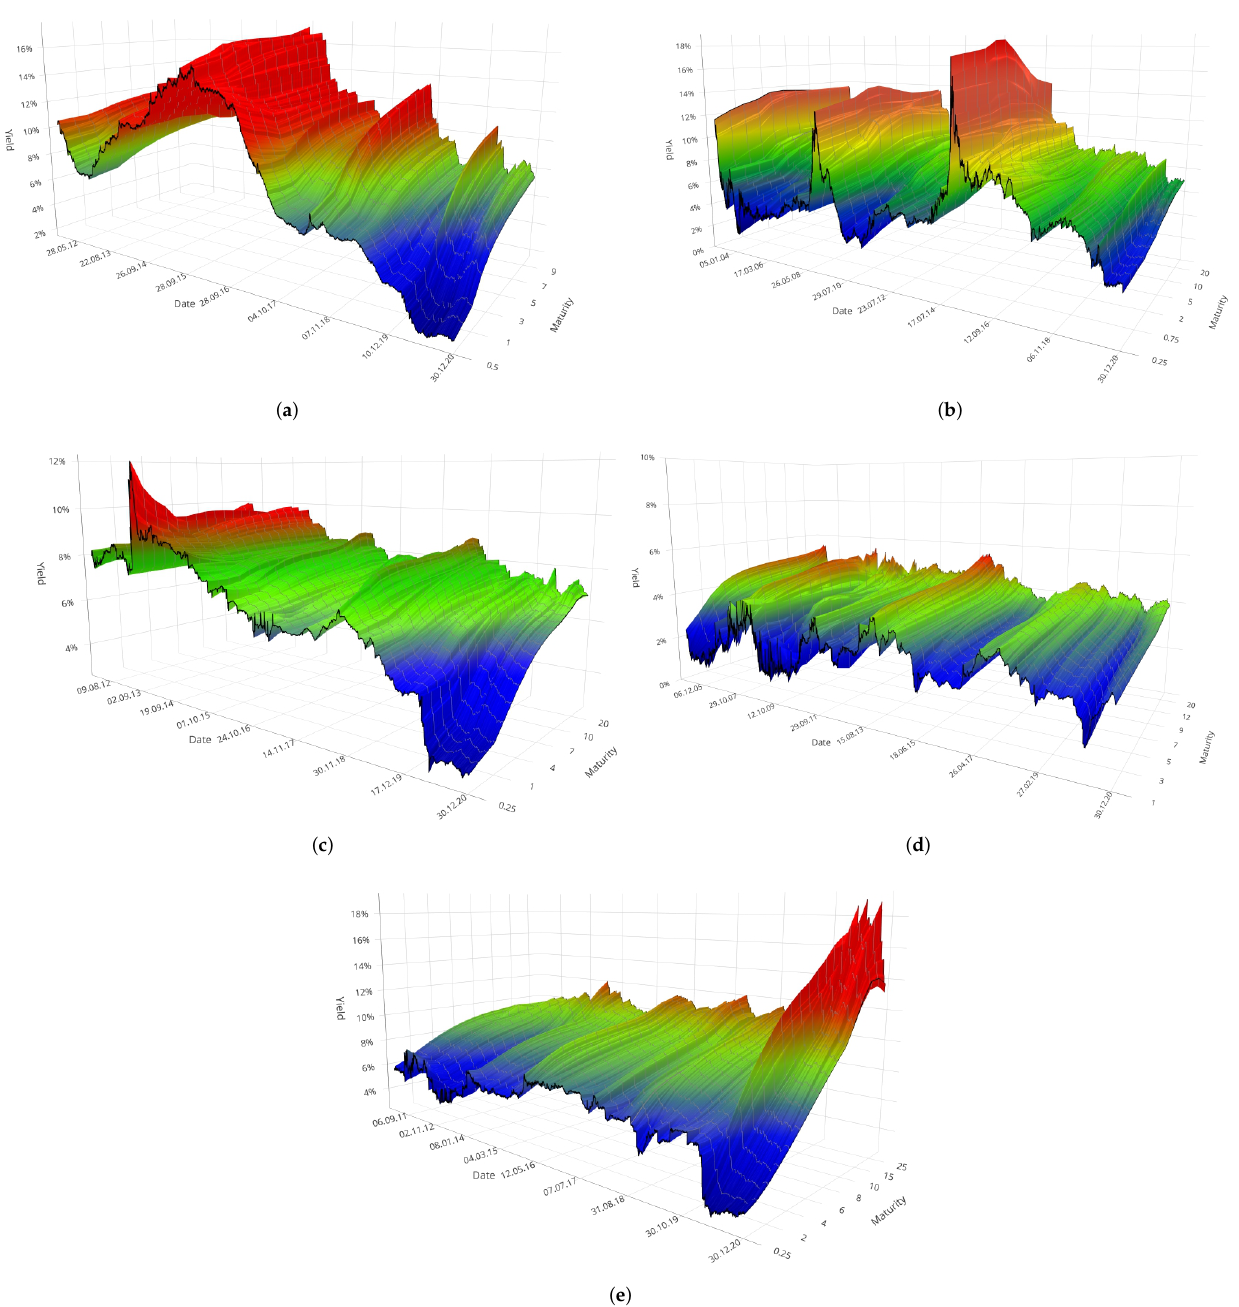
Figure 3. Zero-Coupon yield surfaces of the BRICS countries in the monitored period. From top to bottom and from left to right, ( a ) is associated to Brazil, ( b ) to Russia, ( c ) to India, ( d ) to China, ( e ) to South